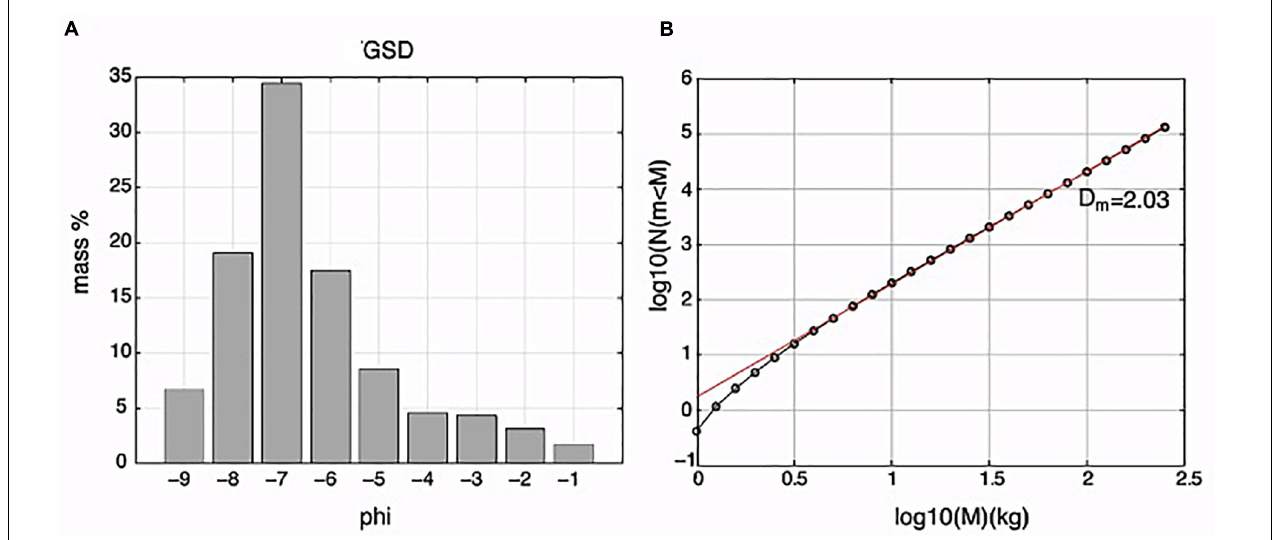
FIGURE 6 | (A) Grain size distribution (mass-based) of the sampled deposit. (B) Log-log representation of the